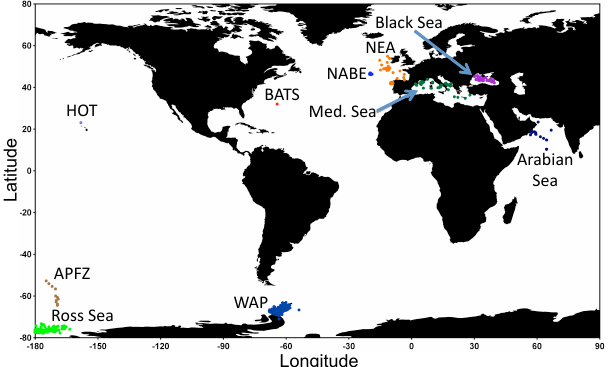
Fig. 1. Sample locations of the 1156NPP measurements among 10 regions. Some of these locations were sampled multiple times (i.e. BATS and